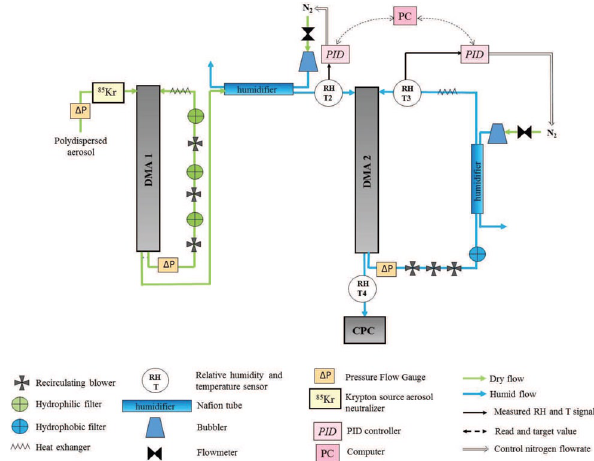
Fig. 2. Schematic diagram showing the layout of the H-TDMA.